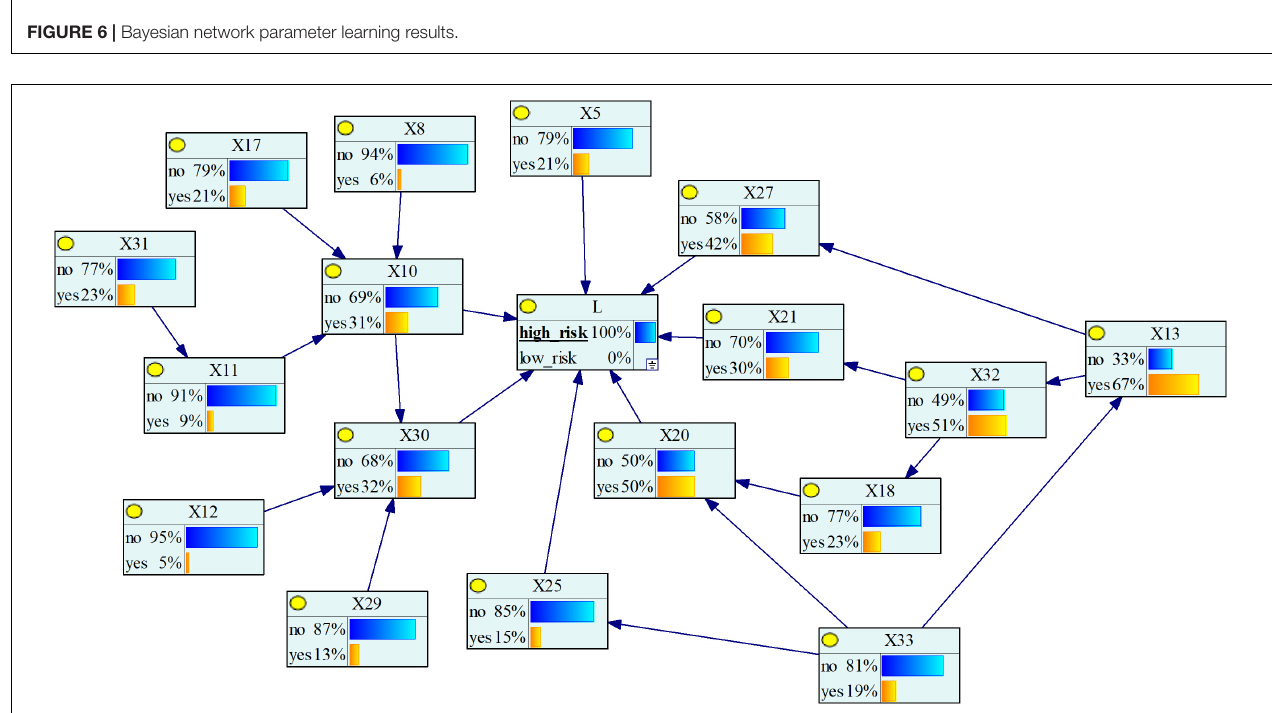
FIGURE 7 | Bayesian network reverse reasoning